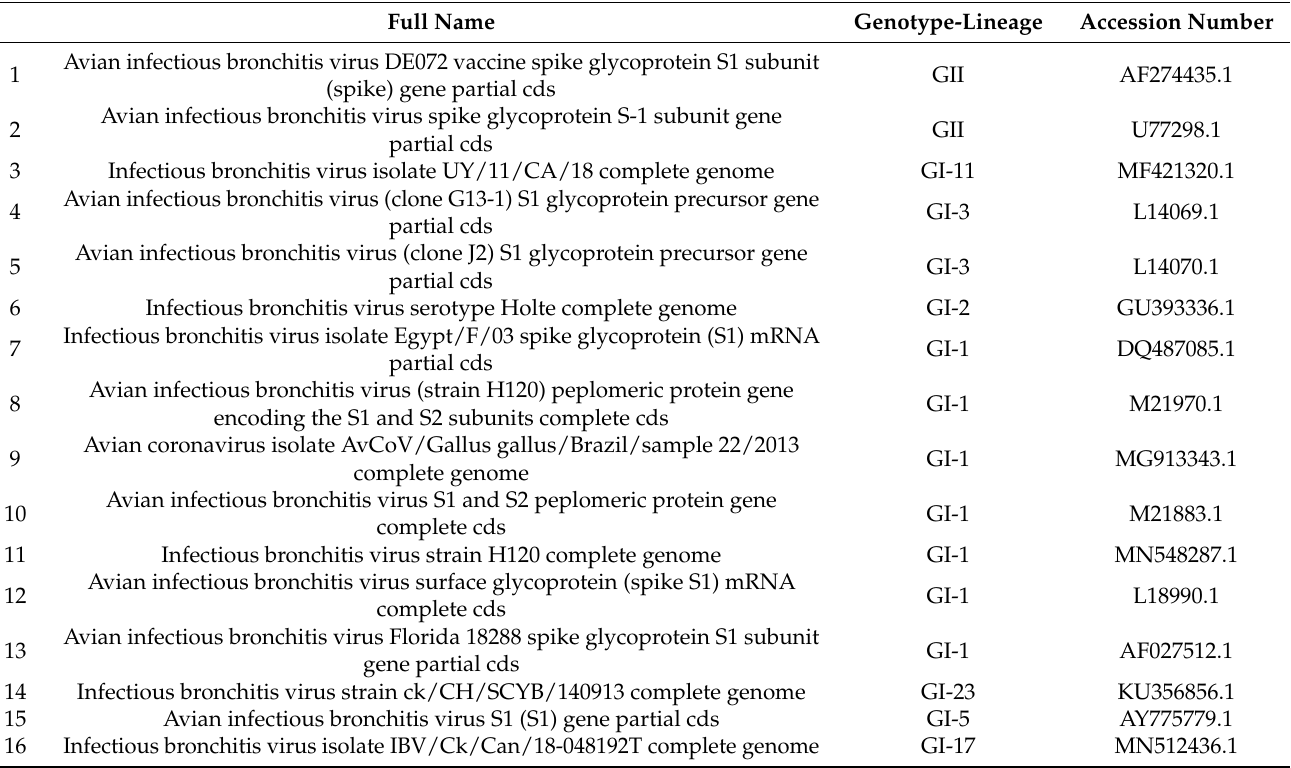
Table A1. Information of nucleotide sequences used for phylogenetic